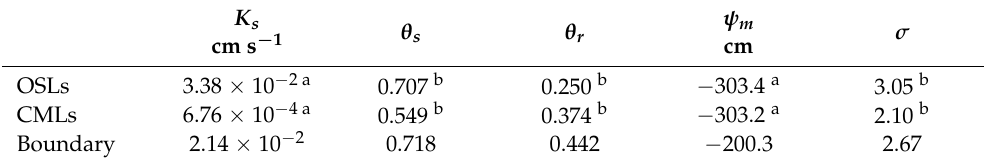
Figure 4. ( a ) Water retention curves and ( b ) hydraulic conductivity curves of the OSLs, CMLs, and boundary zone between the OSLs and CMLs. Table 1. Parameter values for hydraulic